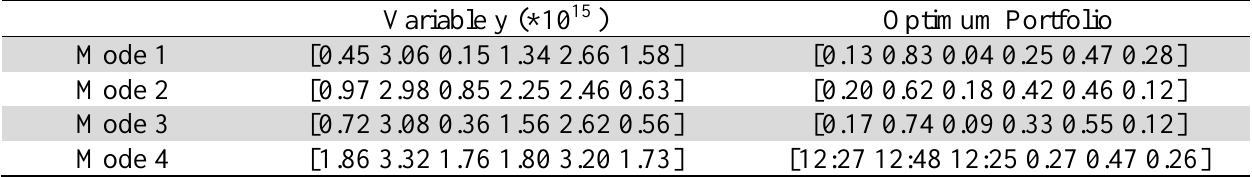
Solution to the problem in the base example in different